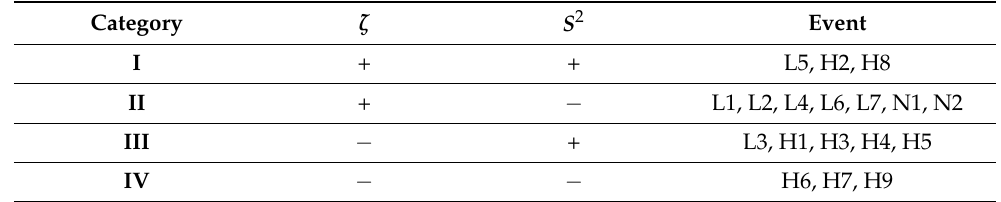
Table 3. Categories and corresponding events of VAR NIW_obs_int events using the two condition parameters of ζ and S 2 for mesoscale fields. The positive and negative anomalies are denoted by plus (+) and minus ( − ) signs referenced to a zero value for ζ and ζ 2 for S 2 during each event, respectively. Category